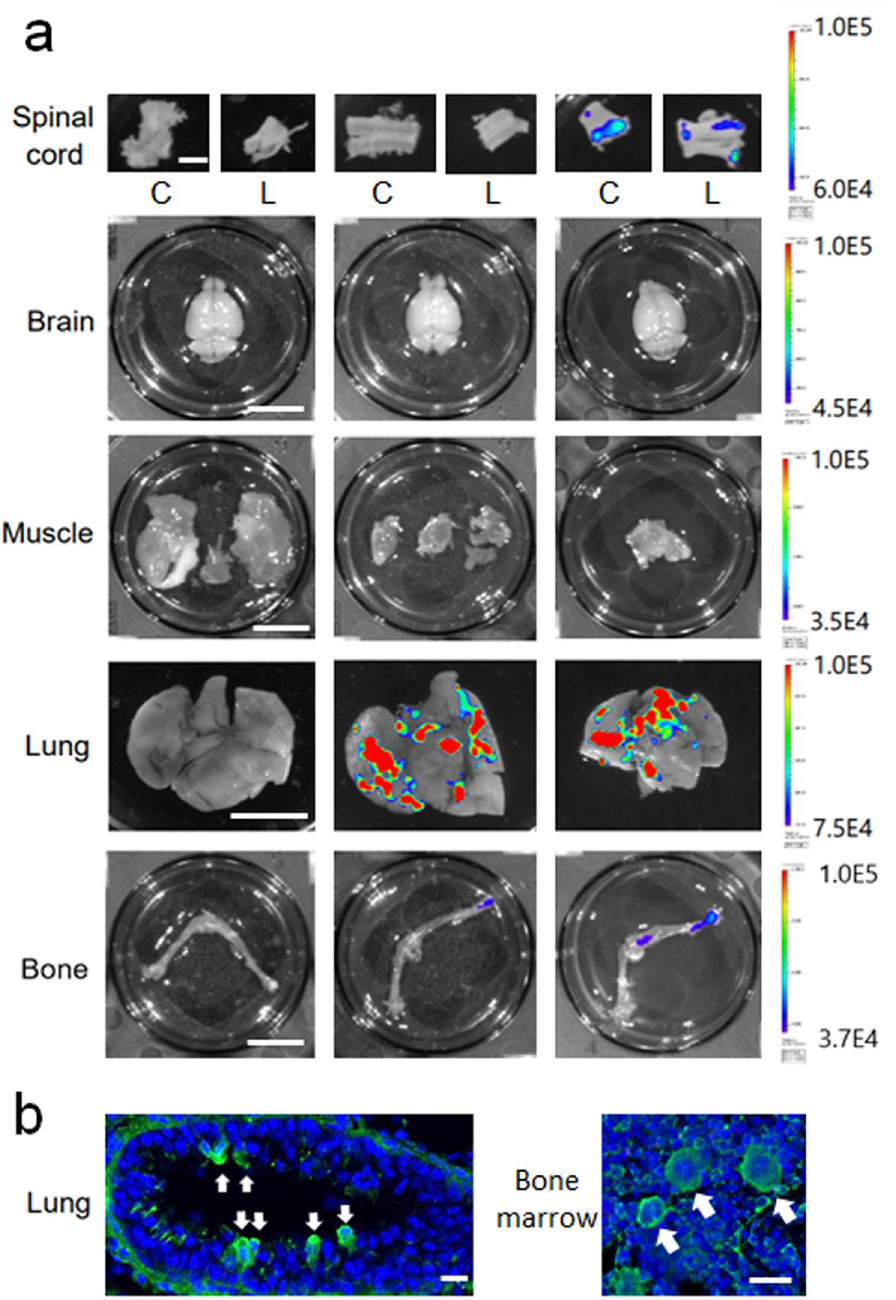
Figure 2. ( a ) Distribution of Nano-lantern-labeled human MSCs and Muse cells in the spinal cord, brain, muscle, lung, and leg bone 7 days after IV administration. Of note, only Muse cells were detected in the spinal cord (c; cervical spinal cord, l; lumbar spinal cord) ( b ) Nano-lantern-labeled Muse cells were found in the pulmonary vessel lumen (left panel, arrows), and in the bone marrow (right panel, arrows). Scale bar in ( a , spinal cord) 2 mm, in ( a , others) 1 cm, and in ( b ) 20